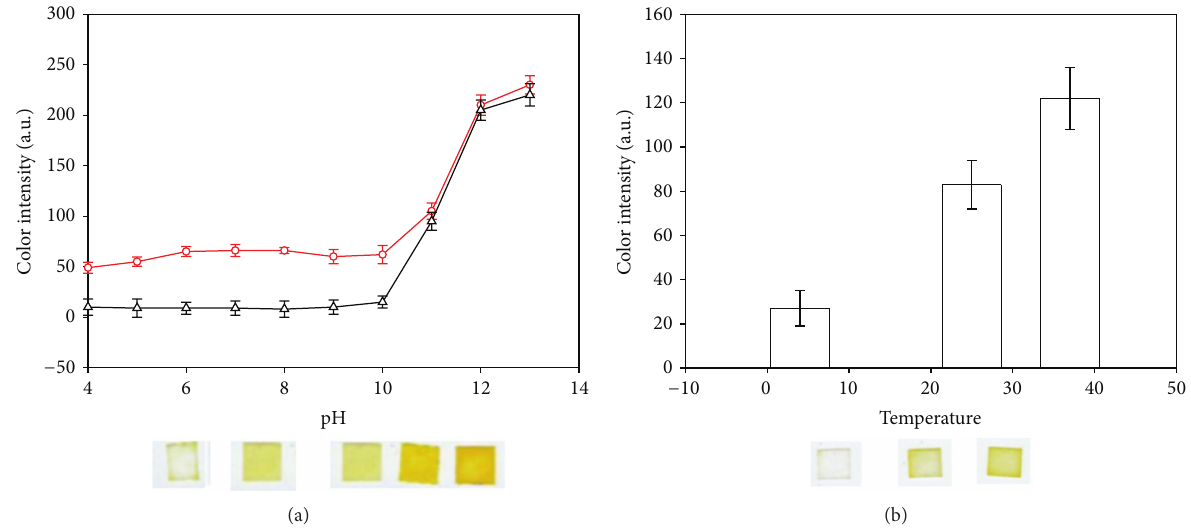
Figure 4: (a) The response of biosensor at different pH values from 4 to 13. Red line (O) is the color intensity of DNTB and ATCh with AChE and black line ( Δ ) represents the color intensity without AChE. (b) Effect of temperature on biosensor response. Vertical bars indicate standard error of